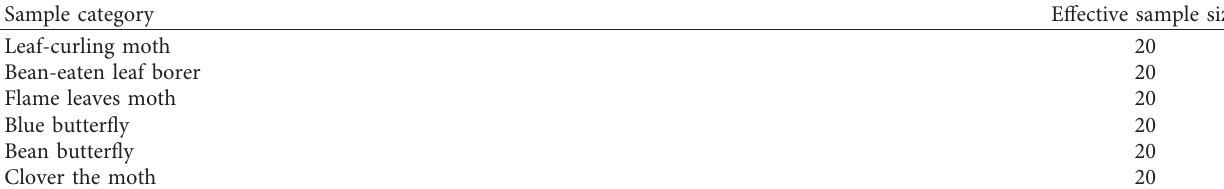
Table 2: The appropriate neural network structure sample